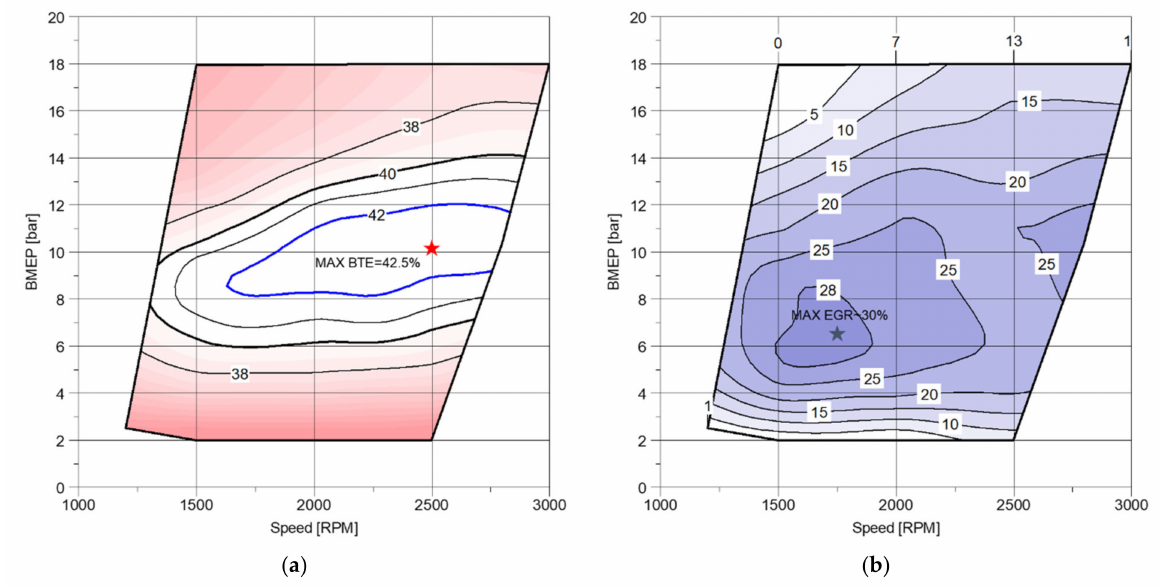
Figure 14. ( a ) Brake thermal efficiency map; ( b ) EGR rate